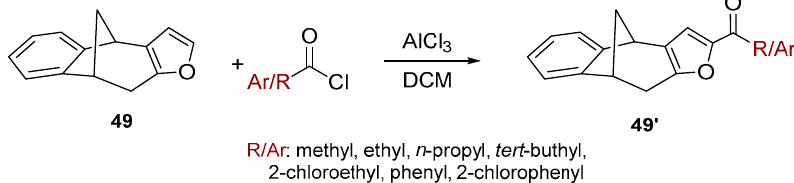
Figure 12. NOESY spectrum of ether endo - 45 .